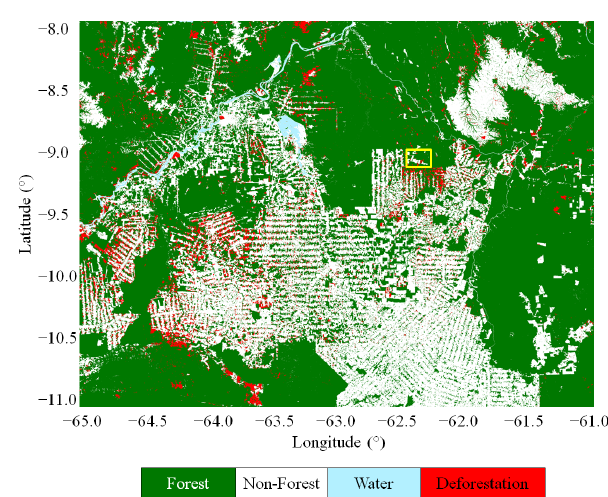
Figure 13. Example of deforestation monitoring in the state of Rondônia, Brazil, between 2013 and 2016. The change map was obtained by differentiating the CNN-FNF maps generated from the TanDEM-X coverages of 2012–2013 and 2016, respectively. The patch highlighted in yellow is investigated in detail in Figure 14.